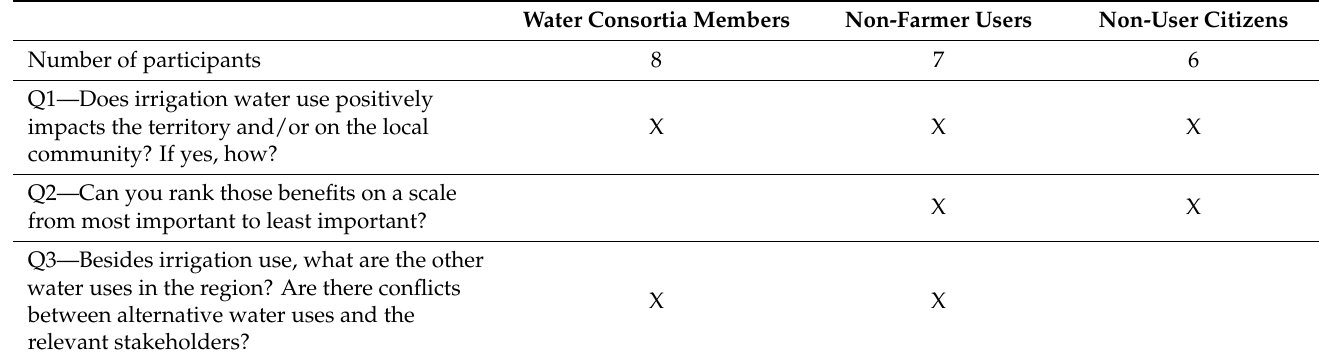
Table 1. Number of focus group participants and questions discussed (marked by an X). Water Consortia